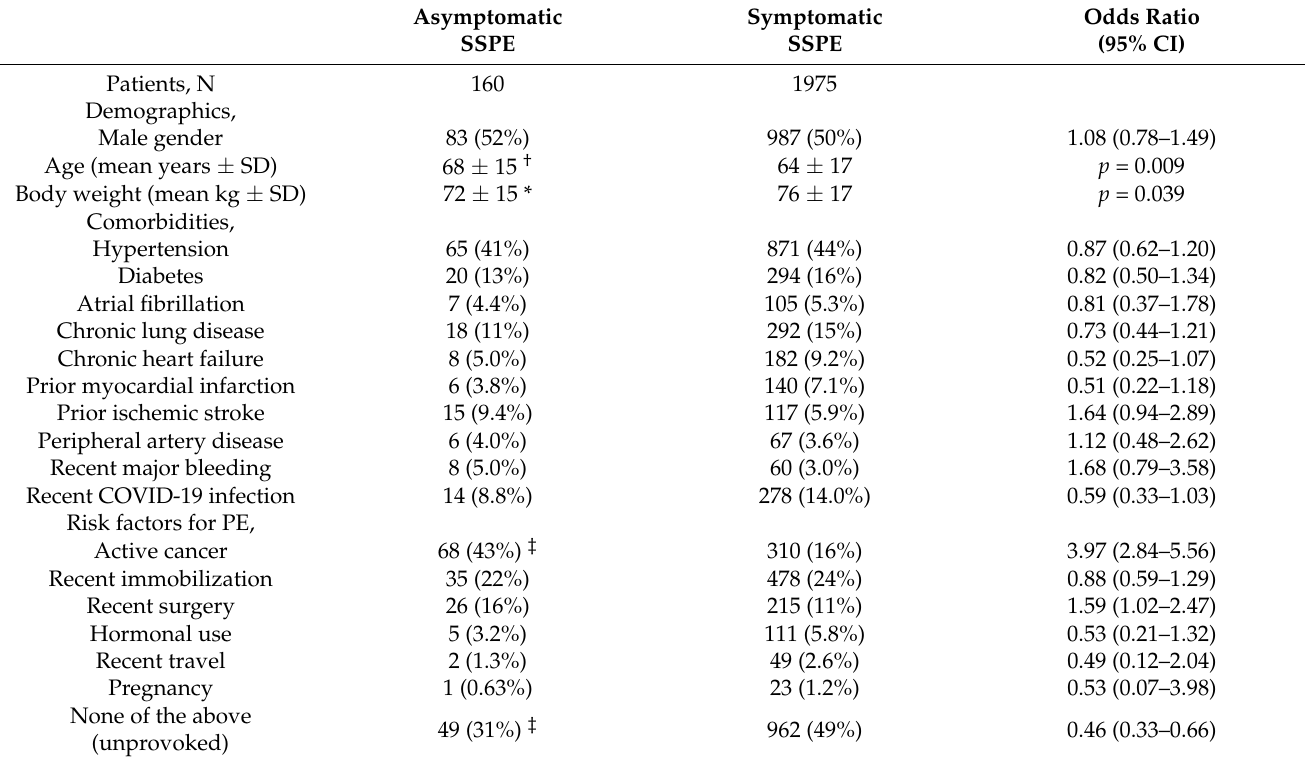
Table 1. Baseline characteristics of patients with symptomatic vs. asymptomatic SSPE. Asymptomatic